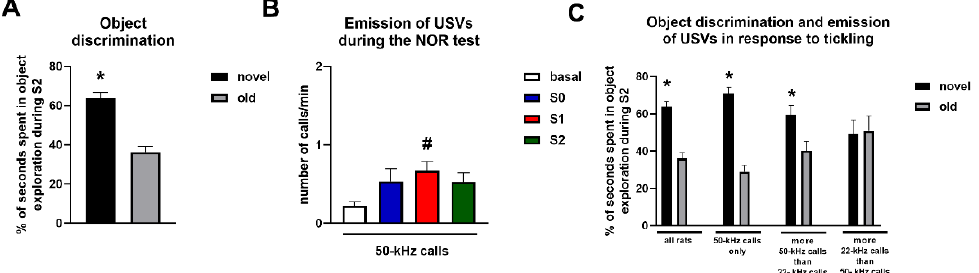
Figure 4. Object discrimination and emission of ultrasonic vocalizations during the novel object recognition test. Panel ( A ) reports the percentage of time spent exploring the novel and old objects in all the rats tested. Panel ( B ) demonstrates the emission of 50-kHz ultrasonic vocalizations in the different sessions of the novel object recognition test. Panel ( C ) reports the percentages of time spent exploring the novel and old objects when rats were grouped according to the prevalent type of ultrasonic vocalizations (i.e., 22-kHz or 50-kHz calls) emitted in response to tickling. * Indicates a significant difference vs. old objects. # Indicates a significant difference vs. basal. NOR = novel object recognition; S0, S1, and S2 = session 0, 1, and 2 of the novel object recognition test. n = 40 for panels A and B and for the group “all rats” in panel ( C ); n = 21 for the group “50-kHz calls only” in panel ( C ); n = 12 for the group “more 50-kHz calls than 22-kHz calls” in panel ( C ); n = 7 for the group “more 22-kHz calls than 50-kHz calls” in panel ( C ).